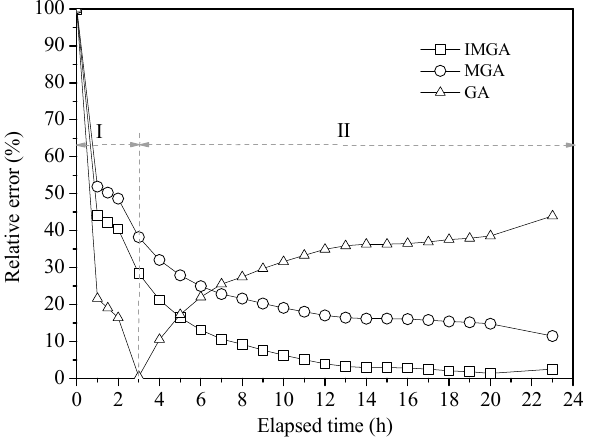
Figure 10. Relative errors of the IMGA, MGA, and GA models as a function of time. I is the period in which the error of GA model degreases. II is the period in which the error of GA model increases.